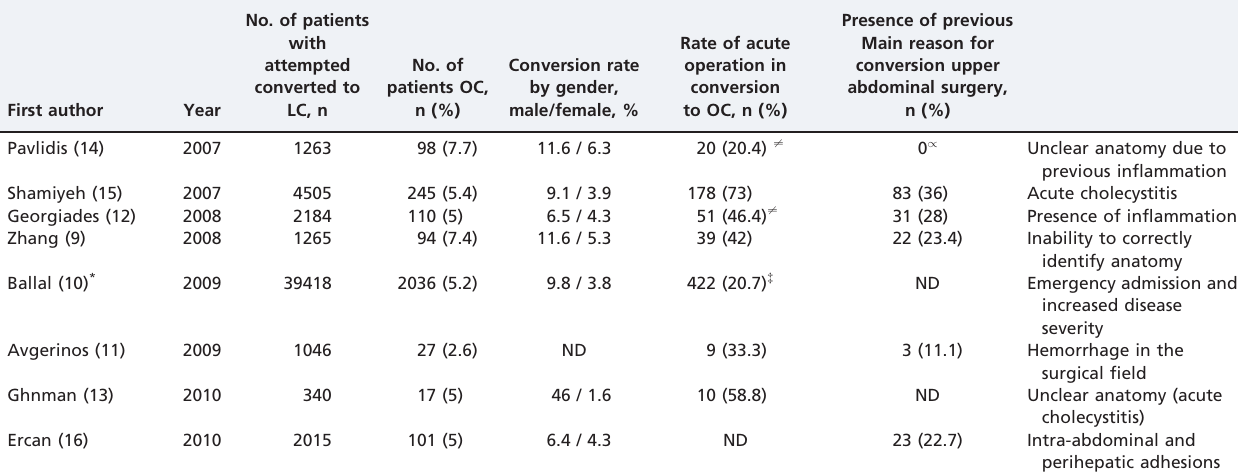
Table 3 - Literature review of reported series of patients requiring conversion to open